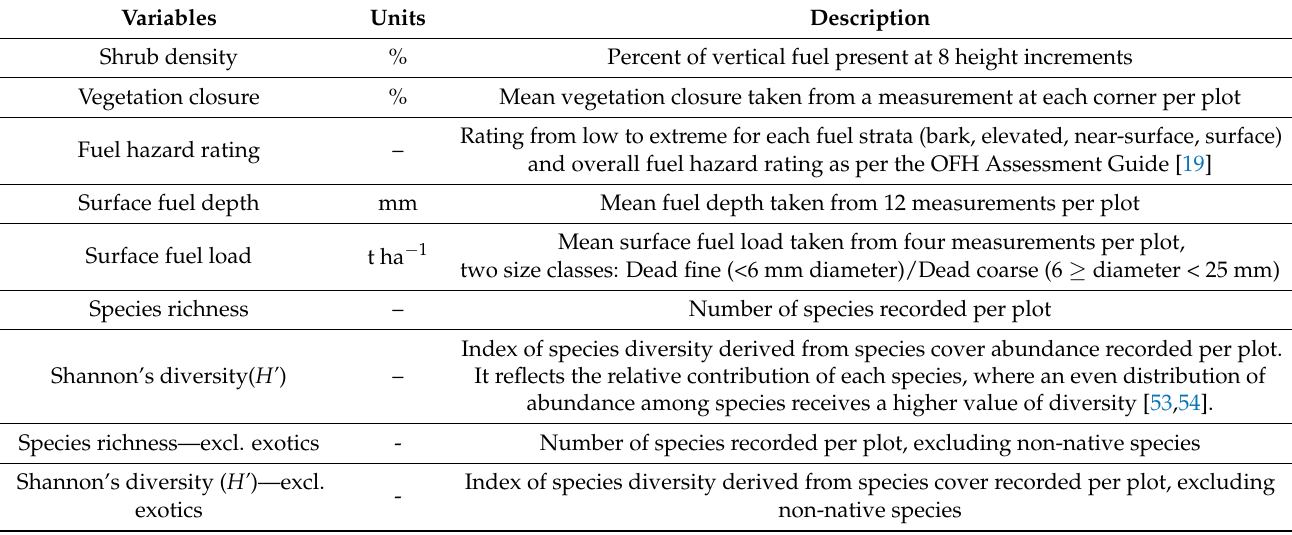
Table 2. Variables derived from field data used to quantify fuel properties and floristic diversity in masticated and control